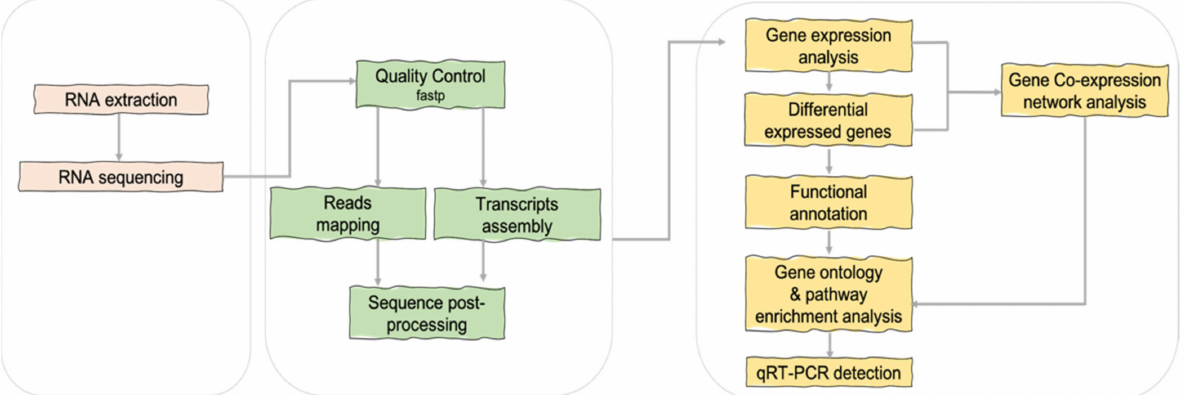
Figure 4. Schematic representation of the papaya RNA-seq analysis using a bioinformatics approach. The potential genes and transcription factor can be validated using qRT-PCR detection, which can be applied in precision breeding through gene editing or marker-assisted selection